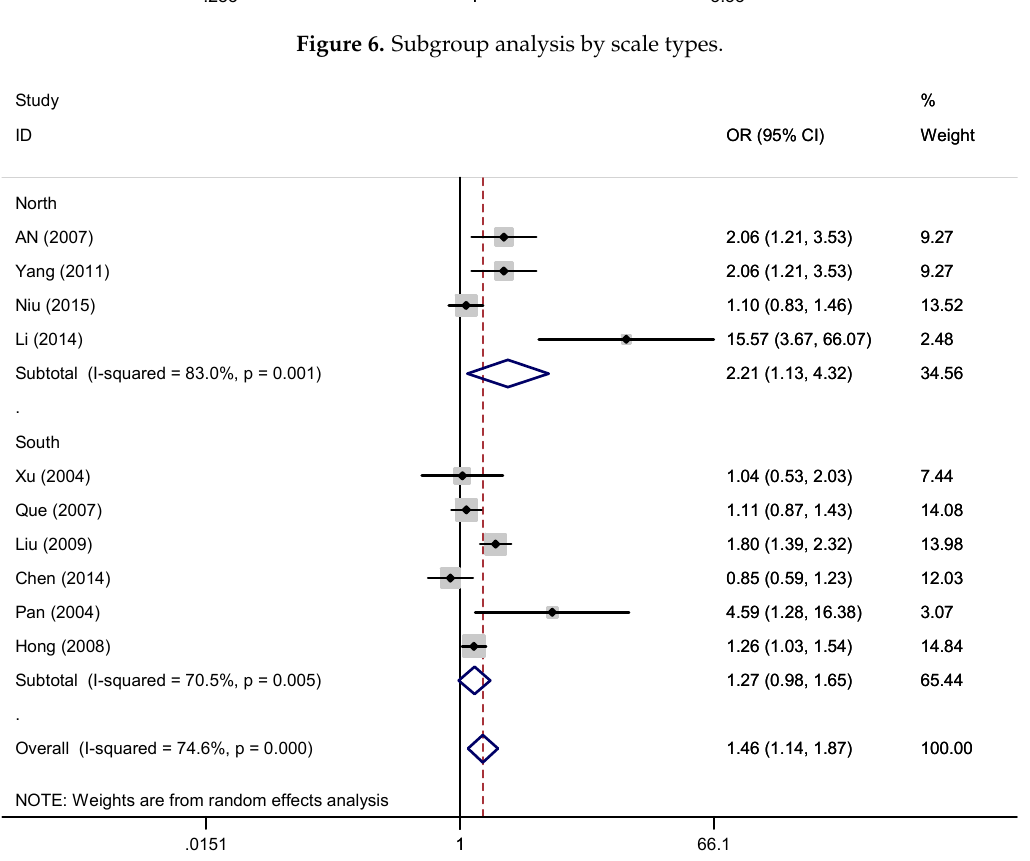
Figure 7. Subgroup analysis by regional distribution.